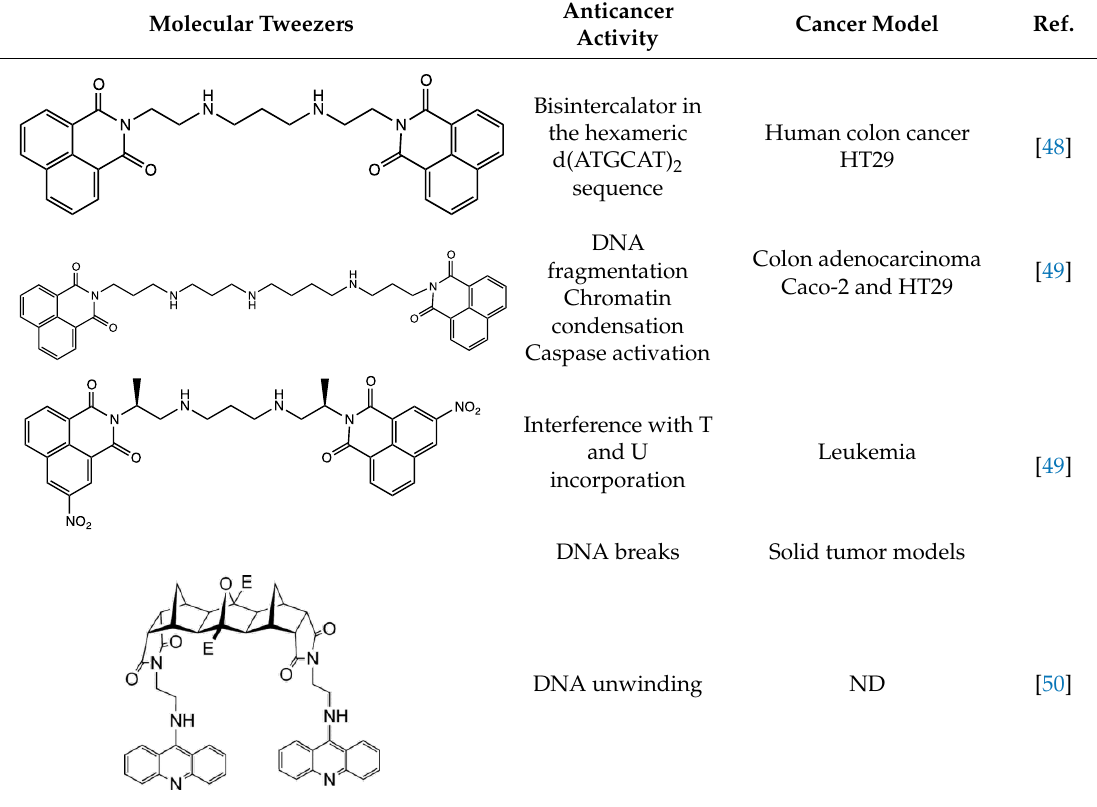
Table 1. Examples of molecular tweezers based on 1,8-naphthalimide with anticancer properties. Adapted from ref [49]. ND: not determined.